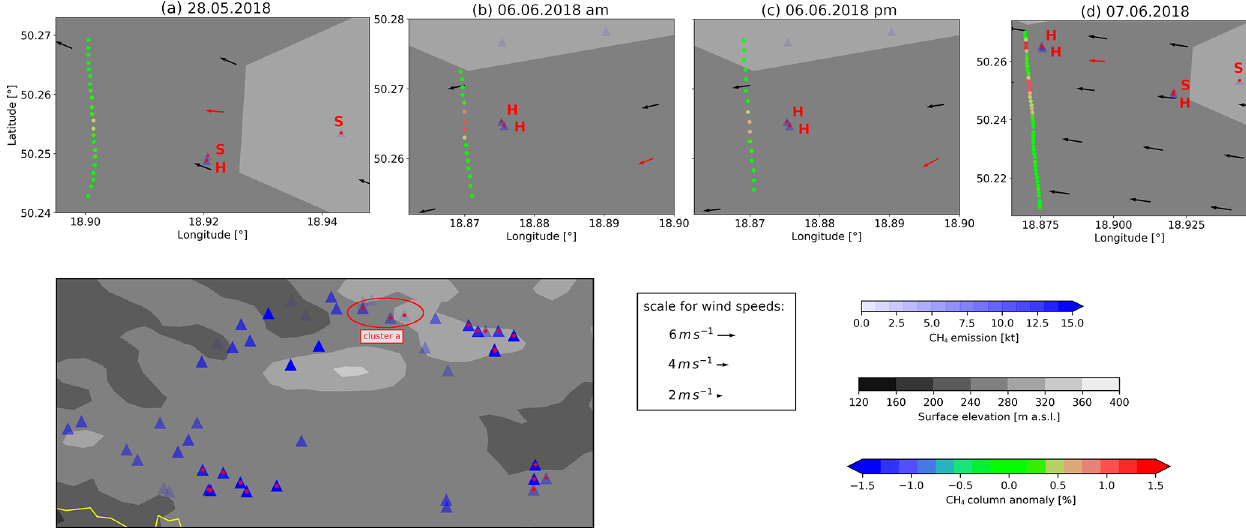
Figure C2. Same as Fig. 5 but for shaft cluster a in the northern part of the study area (H: Halemba, S: ´Sl ˛ask). The corresponding cross- sectional fluxes are summarized in Table C1, and detailed cross-sections are found in Fig. C3.